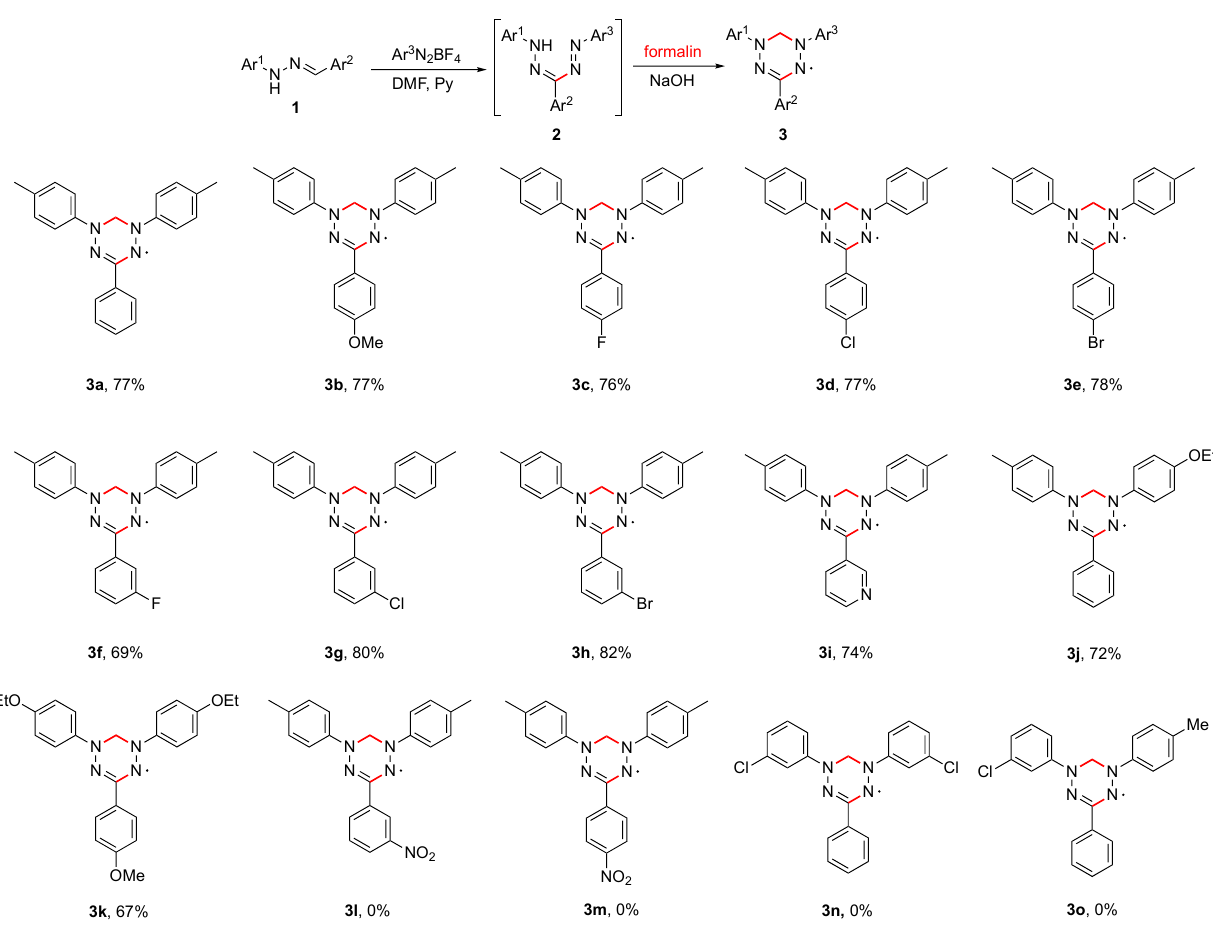
Scheme 2. Substrate scope for the synthesis of verdazyls 3 .